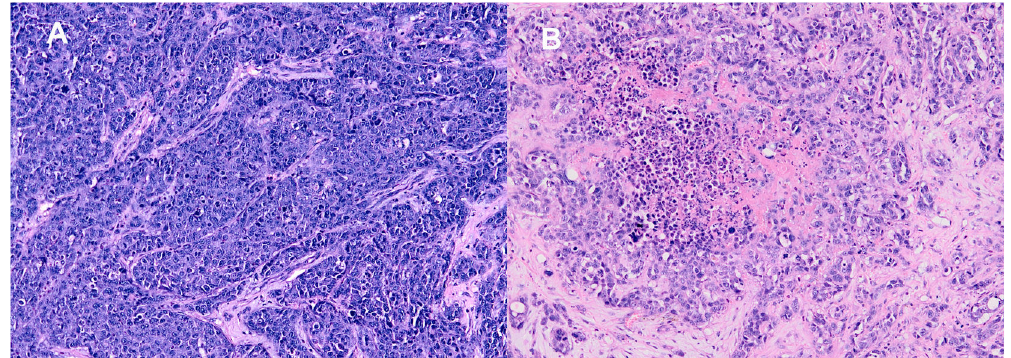
Figure 5. Histopathologic appearance of VX2 liver tumors (H&E, ×100). A shows Viable VX2 cells with obvious nuclear atypia in the periphery of VX2 liver tumor. B shows tumor necrosis in the center of VX2 liver tumor with large size. doi: